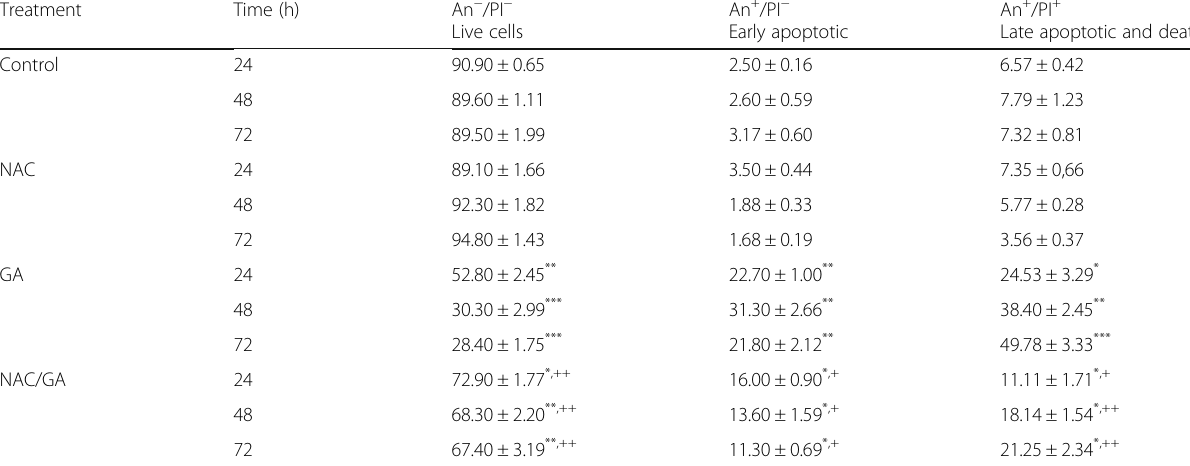
Table 3 Annexin V/PI flow cytometry analysis of apoptosis occurrence in HeLa cells after GA treatment alone and after NAC pre- treatment (in %). The results are presented from 3 independent experiments. Significantly different, * P < 0.05, ** P < 0.01, *** P < 0.001 versus untreated cells (control); + P < 0.05, ++ P < 0.01 versus